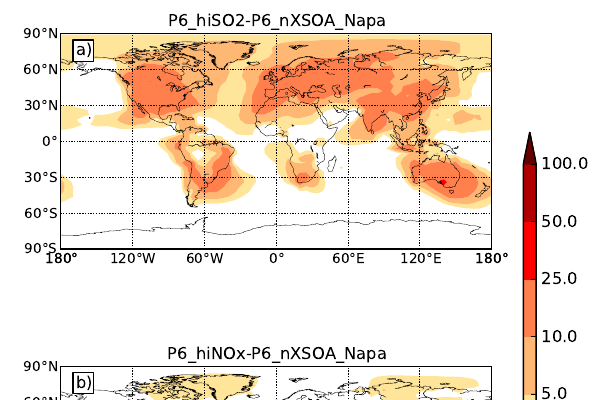
tions P6_hiSO2, P6_hiNOx, and P6_hiboth increase from the P6_nXSOA_Napa simulation by 9.00, 1.47, and 10.24 %,